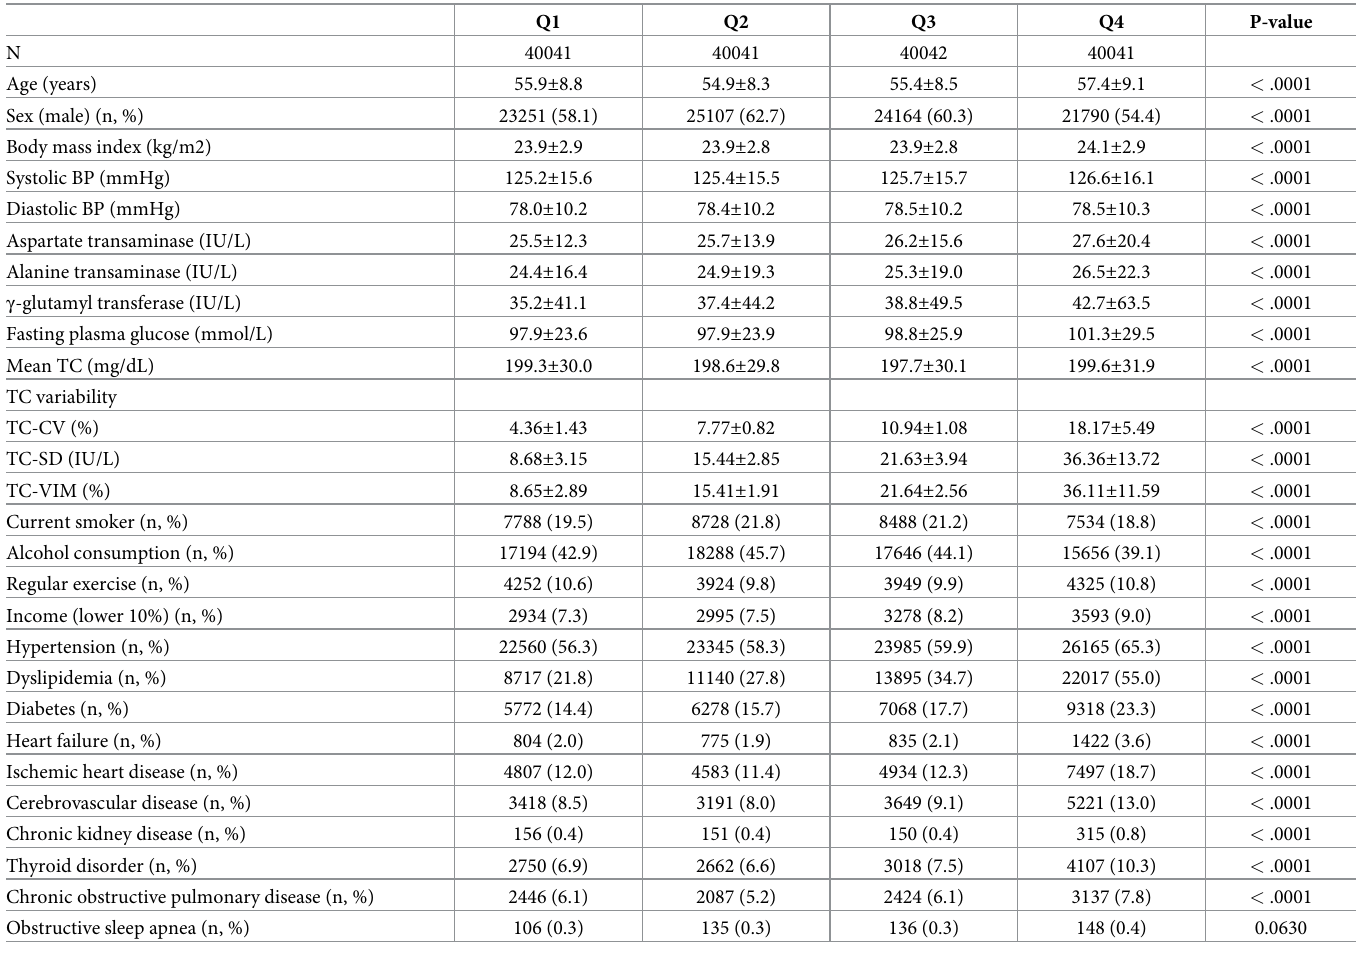
Table 1. Baseline characteristics of subjects according to the total cholesterol